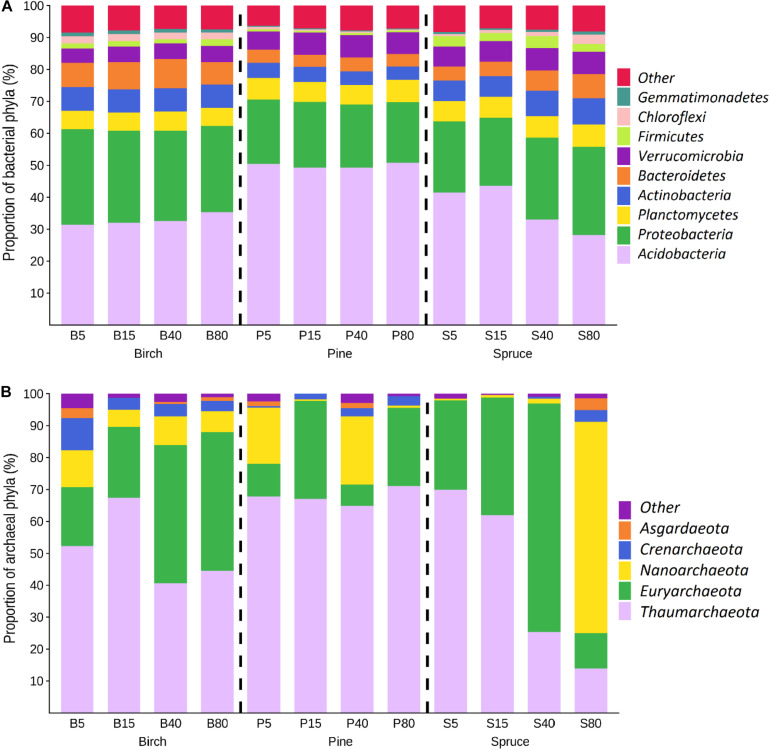
Mean proportions of the most abundant bacterial and archaeal phyla (A,B, respectively; n = 3) in soil samples of the studied stands. Numbers indicate plot distance (in meters) from drainage ditches. Groups with proportions <1% are summed and indicated as Others.